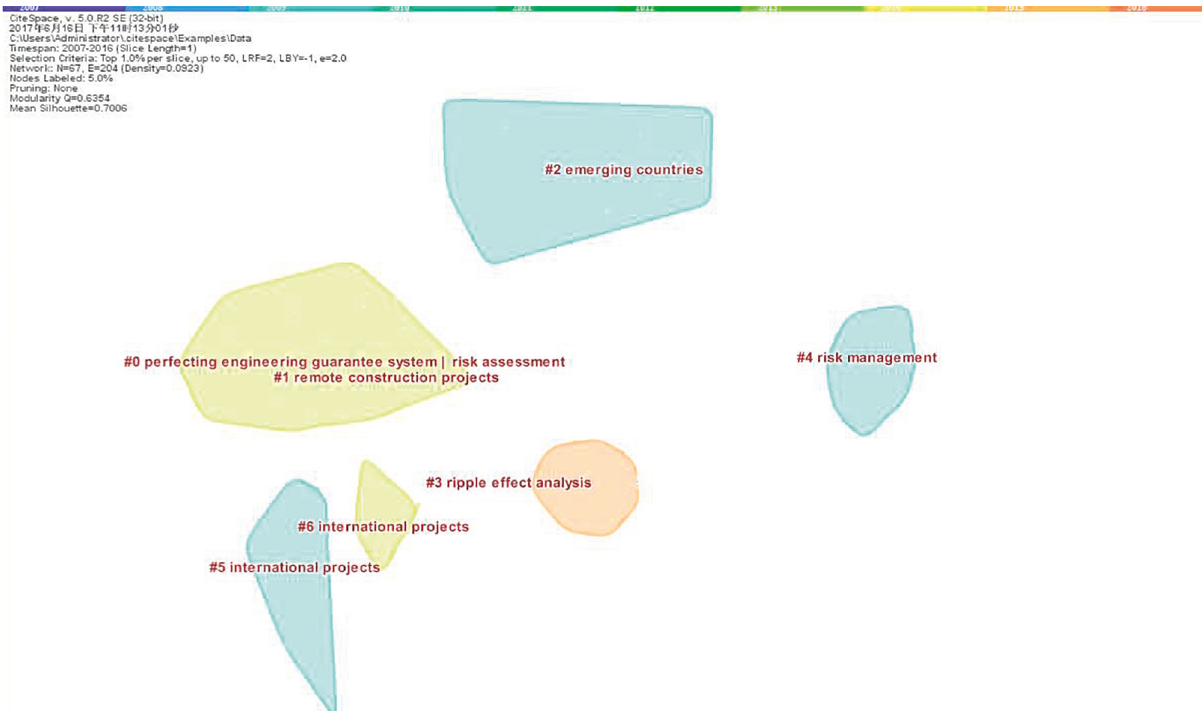
Figure 7: Cluster